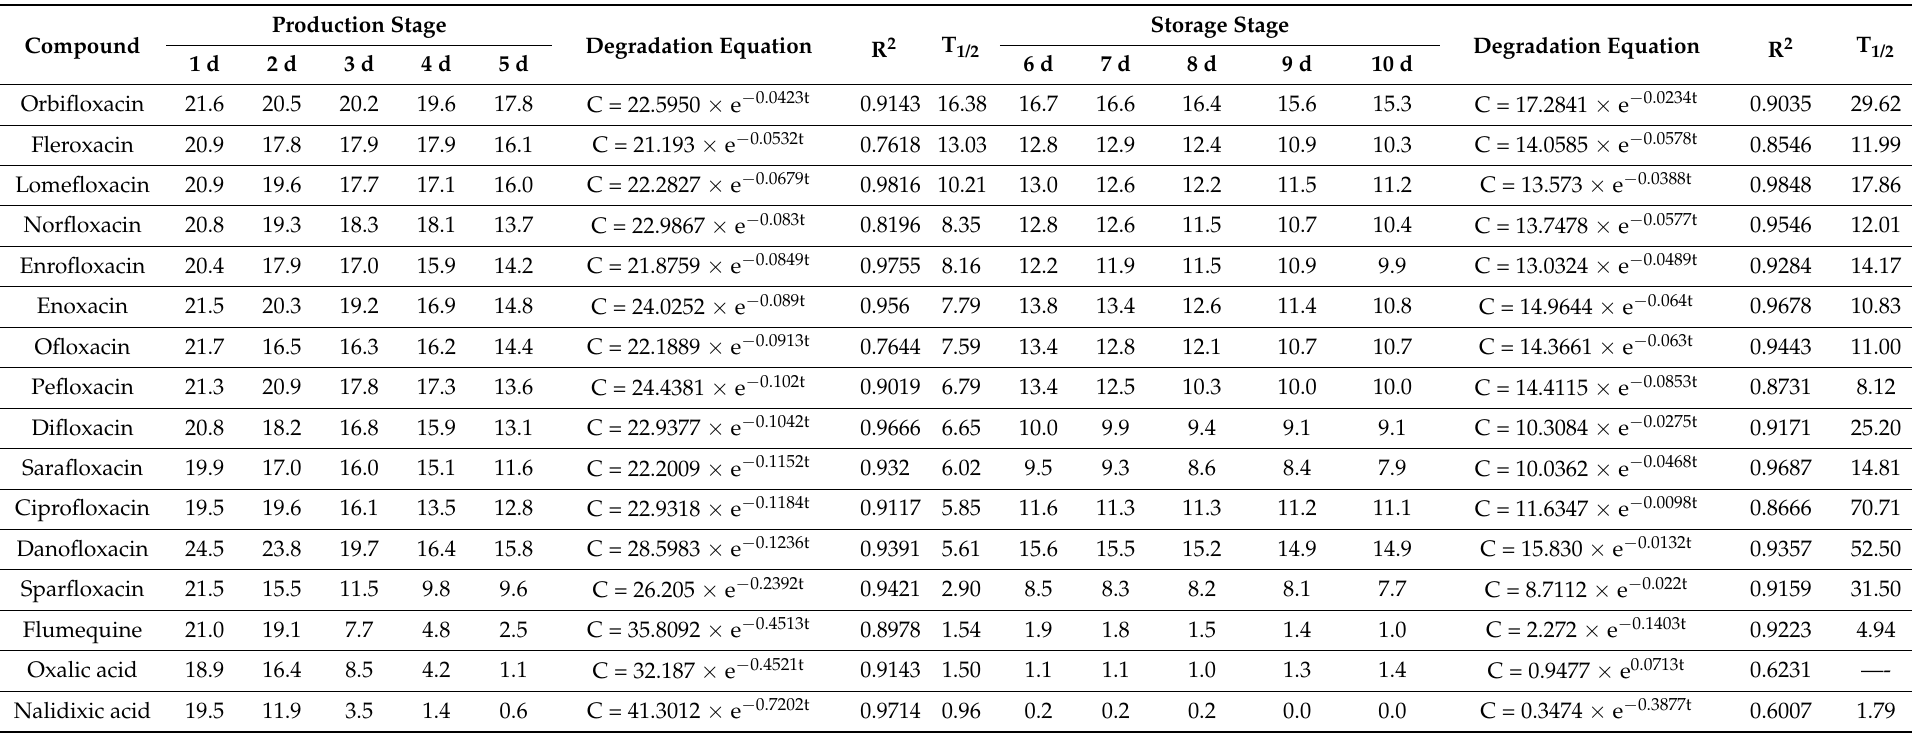
Table 3. Degradation characterization of 16 QNs in production and storage stage of soybean